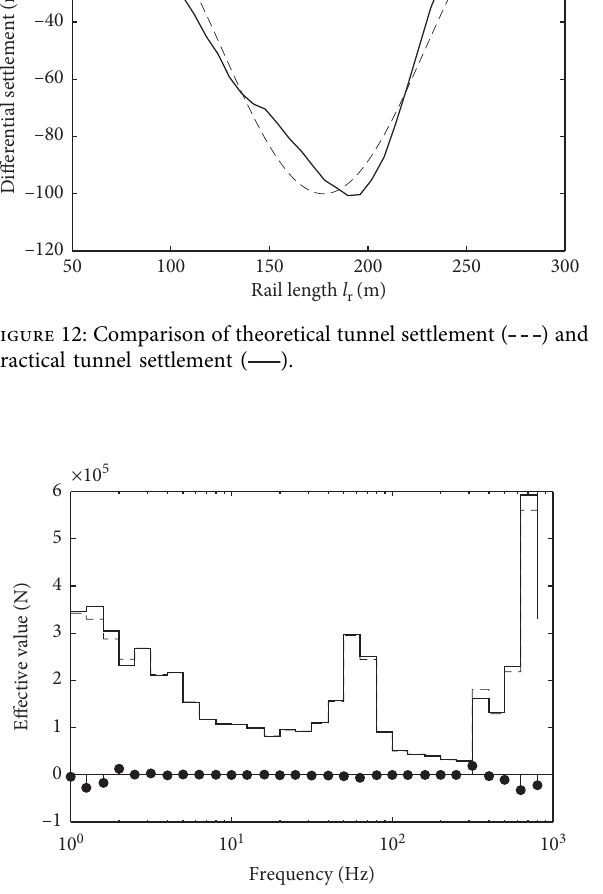
Figure 13: 1/3 Octave band of the wheel-rail contact force ( under practical differential settlement; under theoretical dif- ferential settlement; differences between two